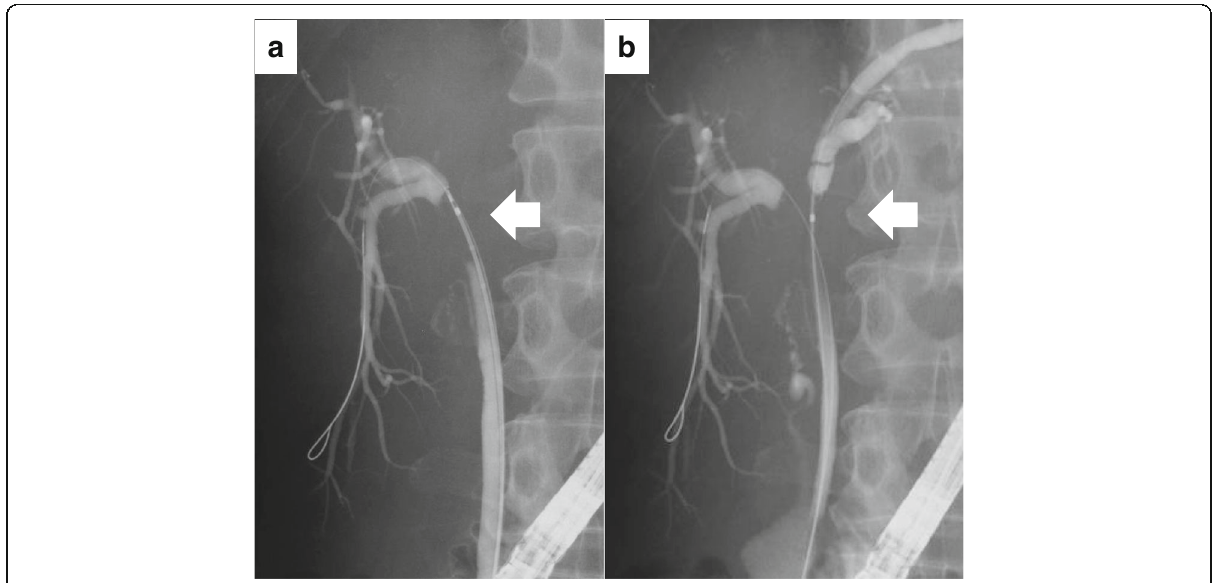
Fig. 3 Endoscopic retrograde cholangiography (ERC) findings. a , b ERC revealed the defect at the bifurcation of the common hepatic duct (Bismuth-Corlette classification type